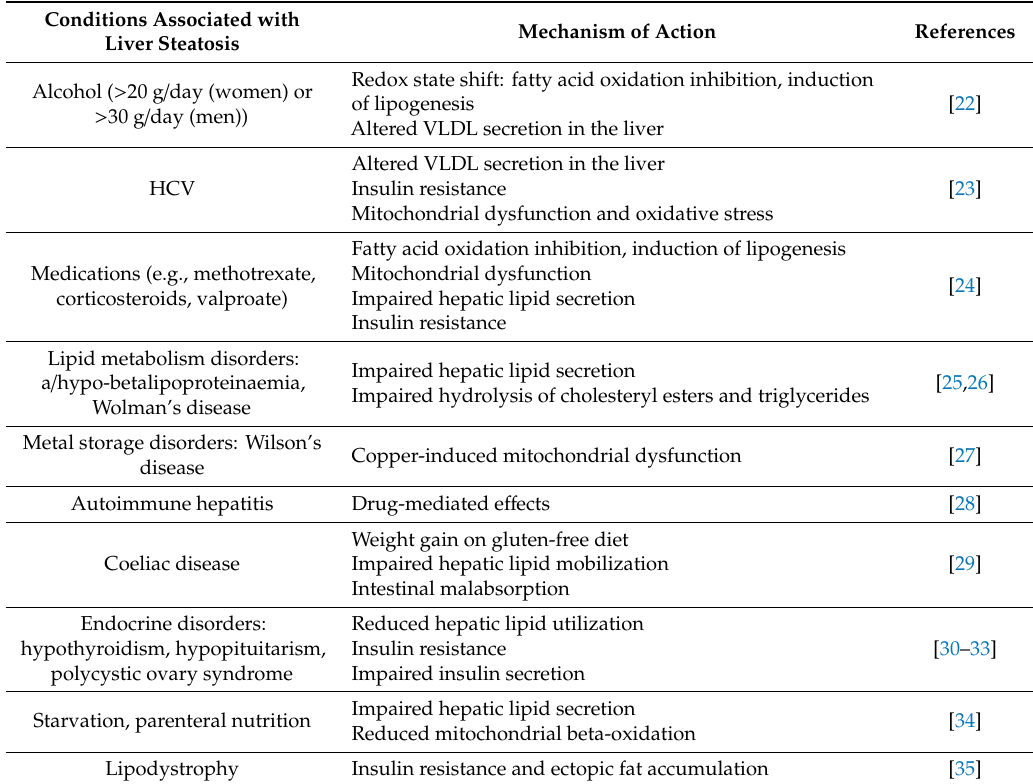
Table 1. Di ff erential diagnosis of NAFLD. Several conditions associated with liver steatosis are shown in this table, with possible pathogenetic mechanisms and associated